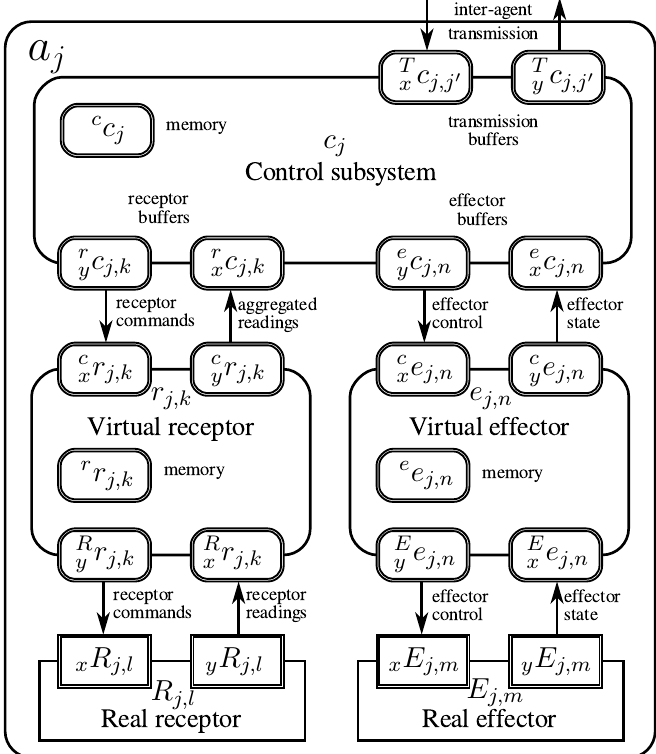
Figure 4. General structure of an embodied agent a j